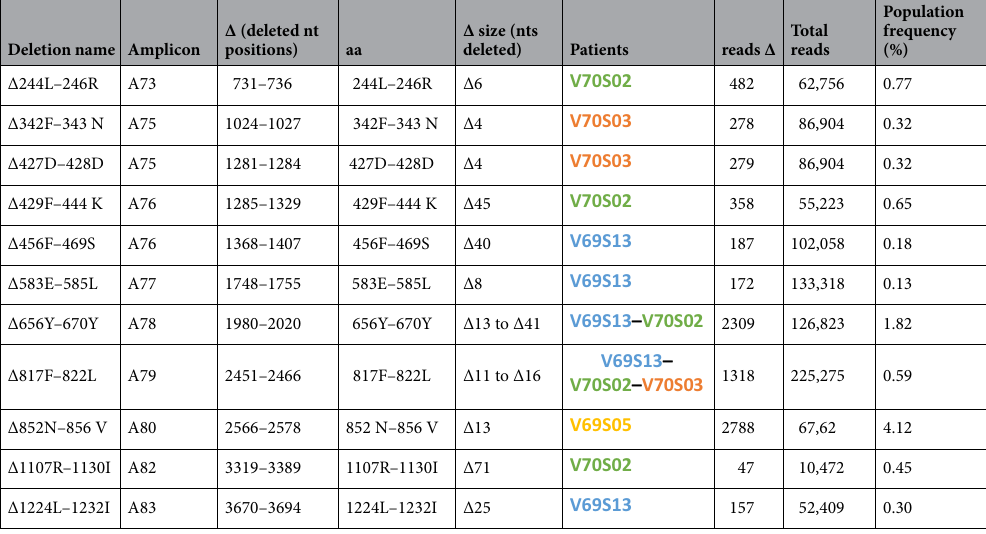
Table 1. Variant